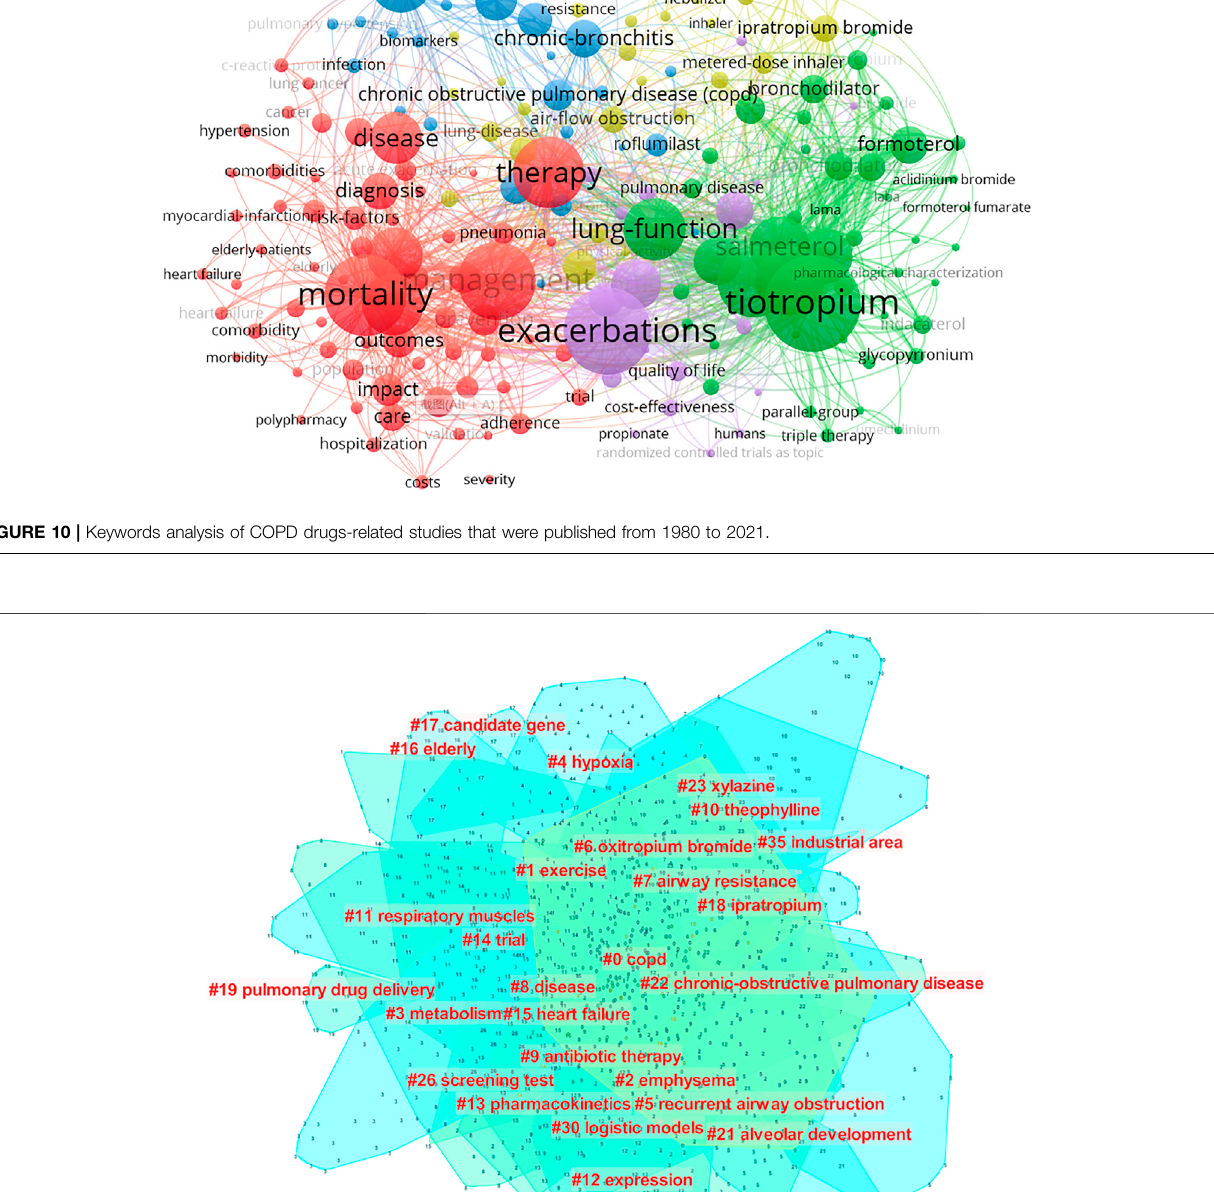
Frontiers in Pharmacology |